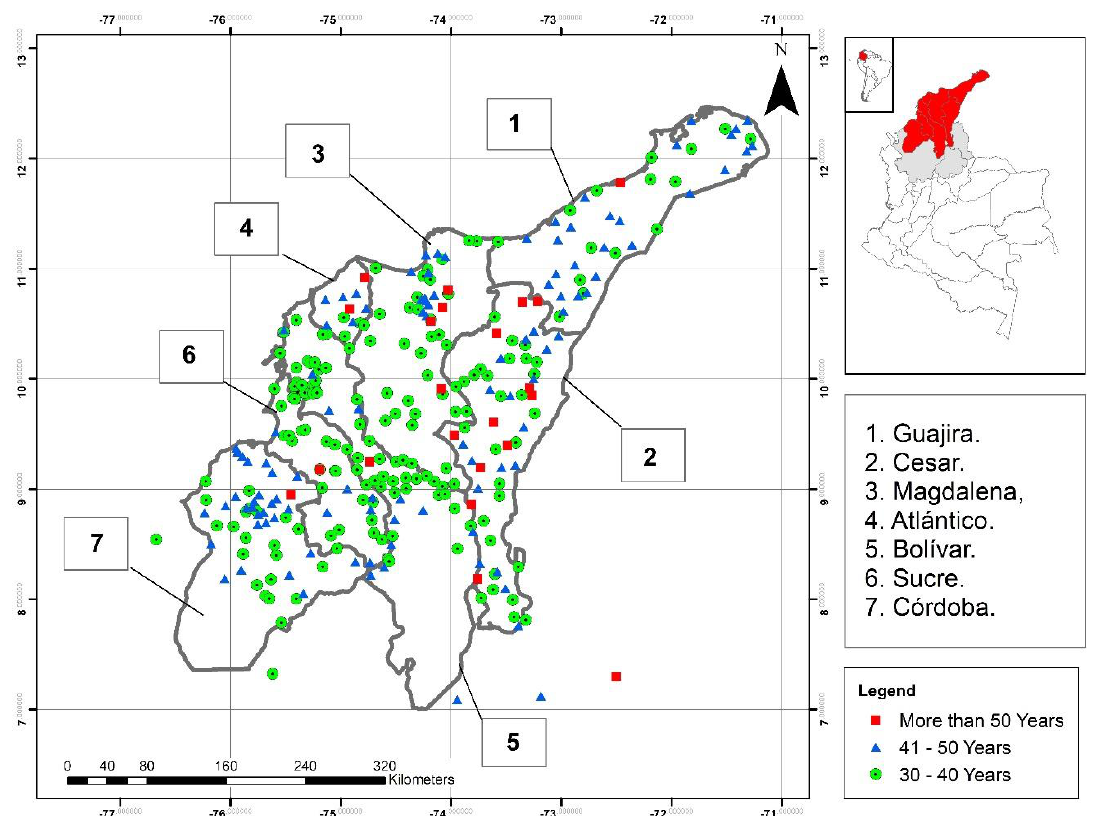
Figure 1. Study area and location of pluviometric stations (gray areas in the upper-right map are, from left to right, the departments of Antioquia, Santander, and Norte de Santander).